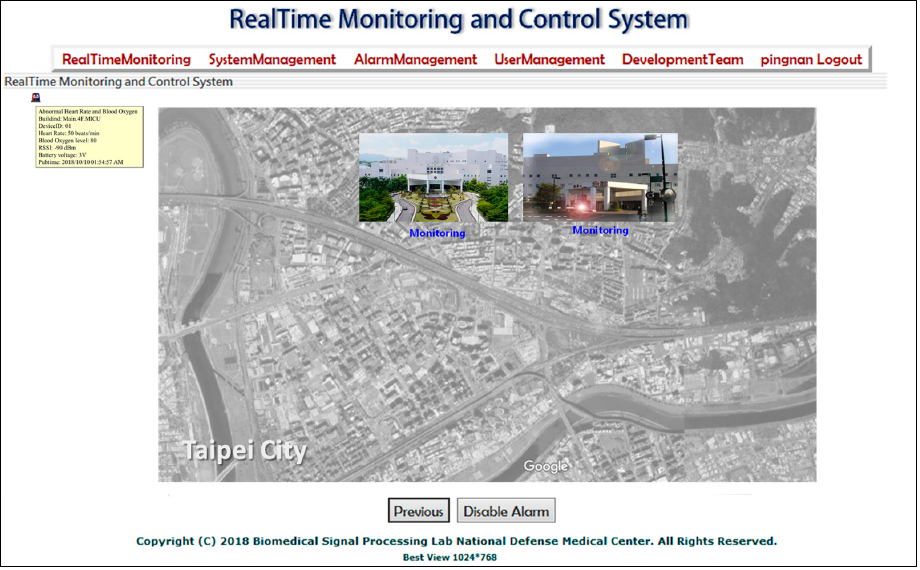
Figure 10. Level 1 real-time graphical monitoring interface page.